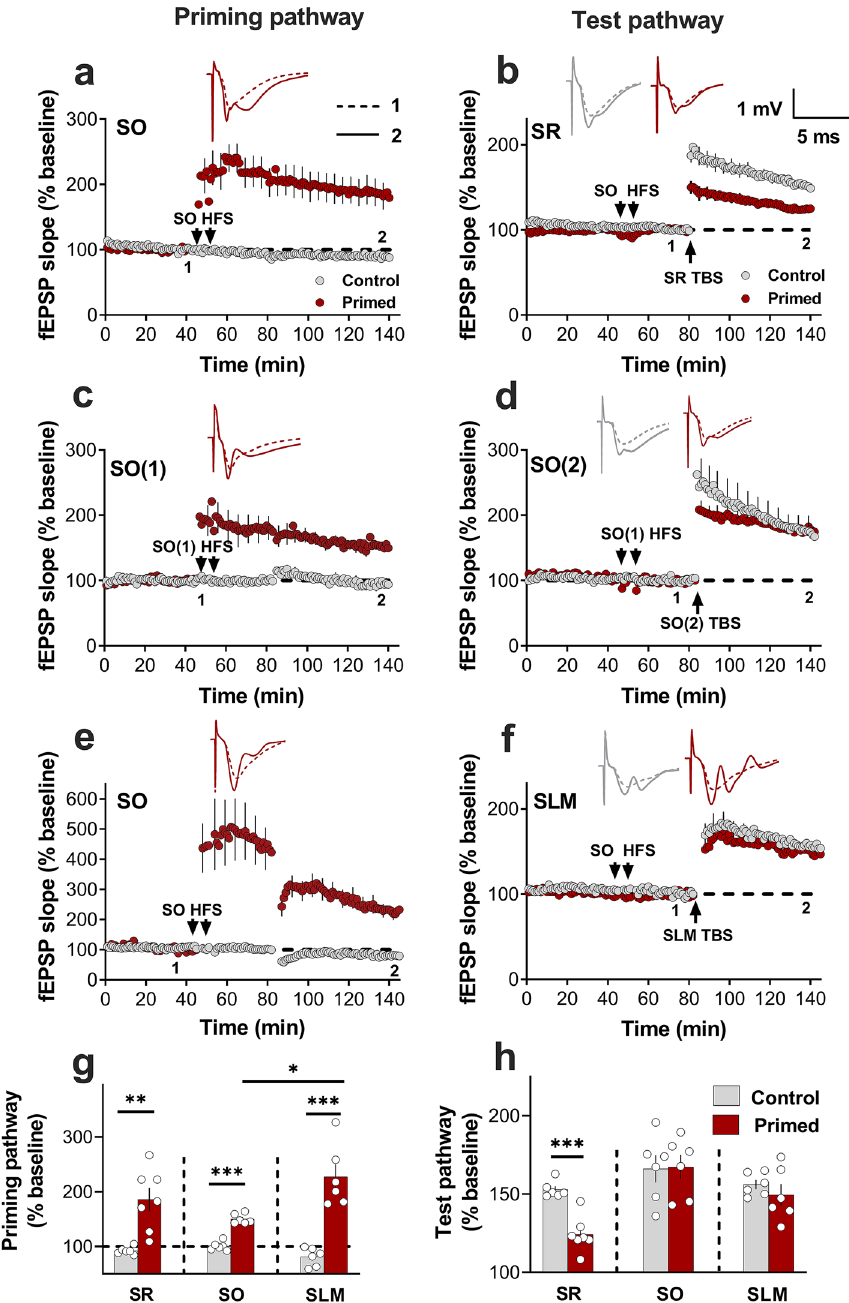
Figure 2. Pathway specificity of HFS priming in SO. ( a ) HFS priming produced significant LTP in the SO primed pathway compared to the control (non-priming) condition (Control = 89.8 ± 4%, n = 5; Primed = 185.9 ± 18%, n = 15; t (10) = 3.7, p = 0.002), and ( b ) produced significant inhibition of LTP in the test SR pathway when compared to the control condition (Control = 152.5 ± 10%, n = 5; Primed = 124.3 ± 6%, n = 7; t (10) = 5.12, p = 0.0004). ( c ) As in ( a ), HFS priming produced significant LTP in SO (Control = 100.6 ± 5%, n = 6; Primed = 150.4 ± 18%, n = 6; t (10) = 10.7, p = 0.0001), but ( d ) had no effect on LTP at neighbouring synapses in the same stratum (Control = 170.5 + 12%, n = 6; Primed = 177.6 + 9%, n = 6; t (10) = 0.2861, p = 0.78). ( e ) In the SLM experiment, HFS priming produced significant LTP in SO (Control = 81.07 ± 7%, n = 6; Primed = 227.3 ± 24%, n = 6; t (10) = 13.03, p = < 0.0001) but ( f ) had no effect on SLM LTP (Control = 156.6 ± 3%, n = 6; Primed = 149.4 ± 8%, n = 6; t (10) = 0.88, p = 0.39). ( g ) Bar graph summarising the homosynaptic LTP in SO across all three experiments. The SO LTP in the SLM experiment was statistically different when compared to that in the SO experiment ( p = 0.02) but not the SO LTP in the SR experiment ( p = 0.243). ( h ) Bar graph summarising the electrical priming effects on LTP in SR, SO and SLM. For the inset waveforms in all figures, 1 represents the average of the final 10 sweeps taken before tetanization in the relevant pathway (pre) and 2 represents the average of 10 sweeps taken 50–60 min after TBS (post) of the test pathway. All data in this and other figures are presented as mean ± SEM; * , p < 0.05; ** , p < 0.01; *** , p <